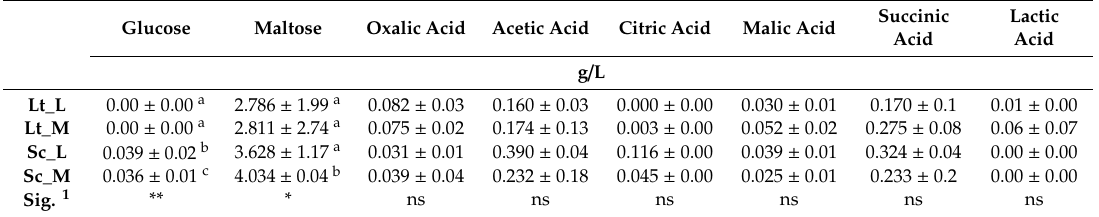
di ff erence in the biosynthesis of organic acids was found in the finished beer (Table 3). A small concentration of lactic acid in the analyzed strain contradicts tests on other L. thermotolerans strains, which evidenced their higher levels. Domizio et al. [19] even described the L. thermotolerans 101 strain as a micro-organism representing a good alternative for sour beer production. The absence of a similar observation prevents the boarder application of the MN477031 strain in brewing across di ff erent styles of beer. Furthermore, only marginal di ff erences in the pH of Lt and Sc beers signify the large potential of the analyzed strain. Table 3. Concentration of glucose, maltose and organic acids in beers hopped with Marynka (M) or Lubelski (L) hop pellets fermented by L. thermotolerans (Lt) or S. cerevisiae (Sc). Succinic Lactic Glucose Maltose Oxalic Acid Acetic Acid Citric Acid Malic Acid Acid Acid g /